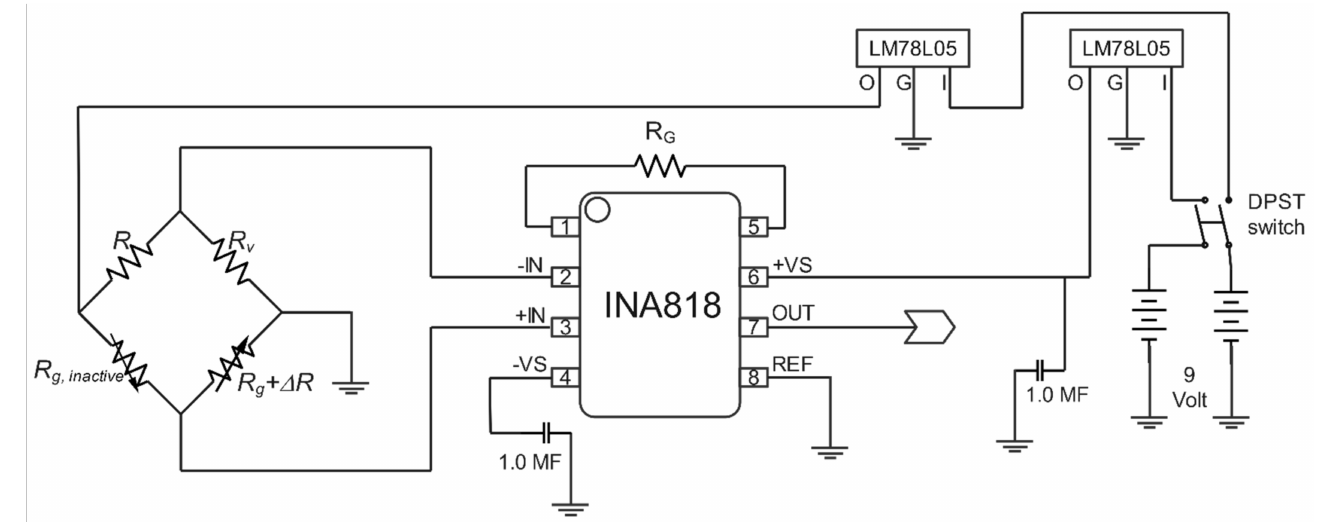
Figure 5. Strain gauge amplifier